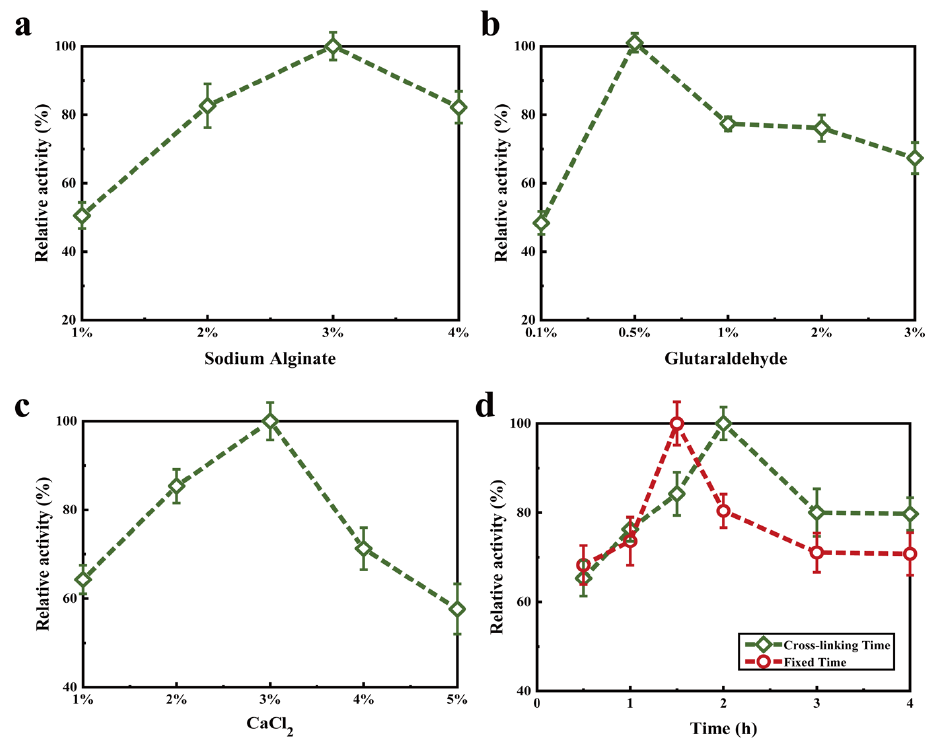
showing good tolerance to alkaline environment (Figure 11d).